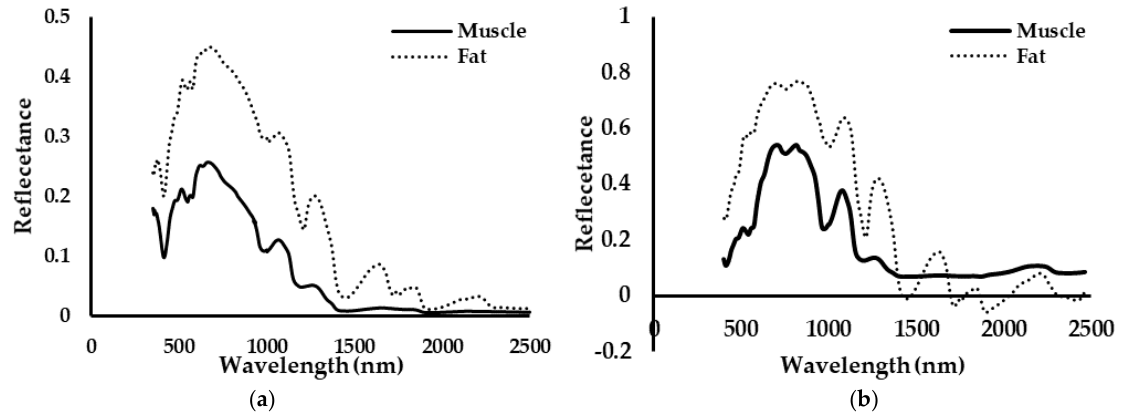
Figure 4. Spectral data of muscle and fat. ( a ) Spectrometer and ( b ) Hyperspectral image ROI mean spectrum. The scaling caused reflectance values to appear outside of the 0–1 range, which only occurs in this figure and not in the data used in the analysis.